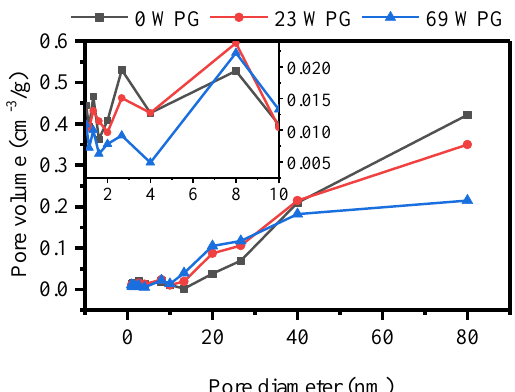
Figure 3. Pore volume versus pore size diameter in modified wood with different weight gain percent (WPG) (0%, 23% and 69%).